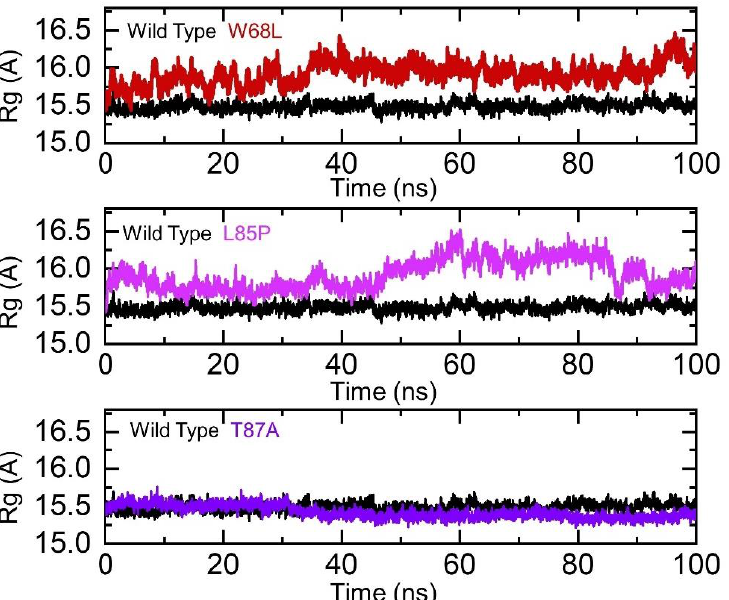
Figure 4. Structural packing of the wildtype and W68L, L85P, and T87A mutants. The wildtype structure is shown as black, W68L (red), L85P (magenta), and T87A